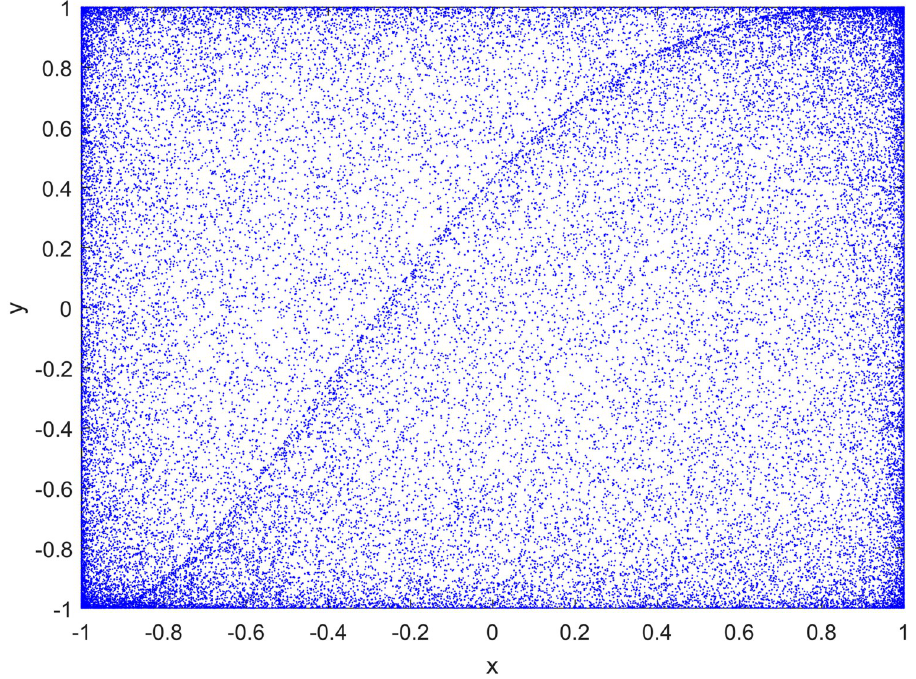
Fig 1. Attractors of 2D-LICM chaotic system with ( a , k ) = (0.6, 0.8).